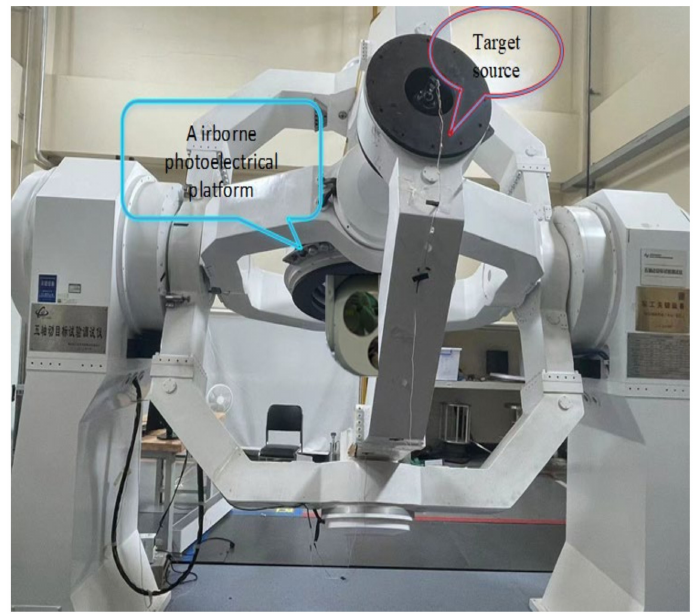
Figure 14. Installation diagram of photoelectric platform for anti-interference experiment.